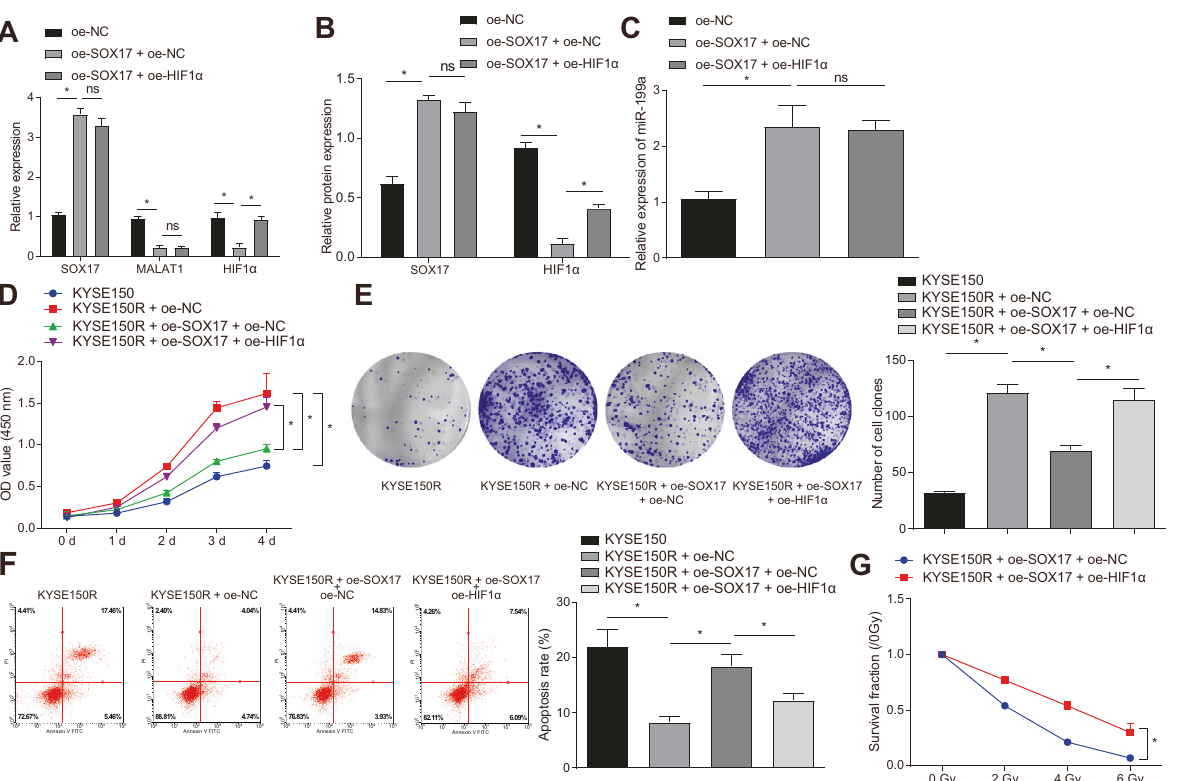
Fig. 6 SOX17 inhibited HIF1 α expression by modulating the MALAT1-miR-199a axis and thus reduced the resistance of ESCC cells to irradiation. A The expression of SOX17, HIF1 α and MALAT1 in KYSE150R cells in response to oe-SOX17 alone or combined with oe-HIF1 α measured by qRT-PCR. B The protein expressions of SOX17 and HIF1 α in KYSE150R cells in response to oe-SOX17 alone or combined with oe- HIF1 α examined by Western blot. C The expression of miR-199a in KYSE150R cells in response to oe-SOX17 alone or combined with oe-HIF1 α measured by qRT-PCR. D The survival rate of KYSE150R cells in response to oe-SOX17 alone or combined with oe-HIF1 α examined by MTT assay. E The proliferation ability of KYSE150R cells in response to oe-SOX17 alone or combined with oe-HIF1 α assessed by clonogenic assay. F The apoptosis of KYSE150R cells in response to oe-SOX17 alone or combined with oe-HIF1 α evaluated by fl ow cytometry. G The proliferation ability of KYSE150R cells in response to oe-SOX17 alone or combined with oe-HIF1 α measured by clonogenic assay. * p < 0.05, ns, not signi fi cant. Measurement data were presented as mean ± standard deviation. One-way ANOVA with Tukey ’ s post-hoc test was employed to analyze data of multiple groups. Two-way ANOVA followed by Bonferroni post-hoc test was adopted to compare the data among multiple groups at different time points. Cell experiments were repeated for three